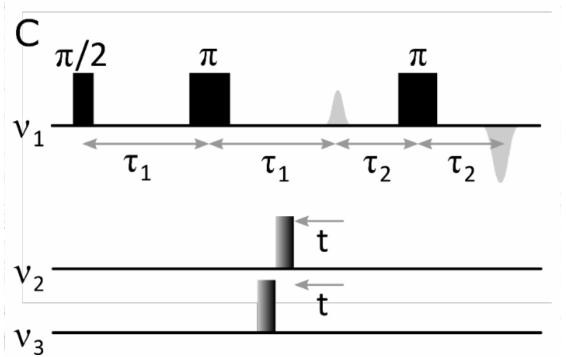
Figure 1. ( A ) The standard dead-time free 4-pulse double electron-electron resonance (DEER) sequence [44] with a refocused echo in the observe channel ( ν 1); ( B ) a 4-pulse DEER sequence using two consecutive chirped pump pulses generated with an AWG on the pump channel [36]; ( C ) a new rDEER sequence with two consecutive chirped pump